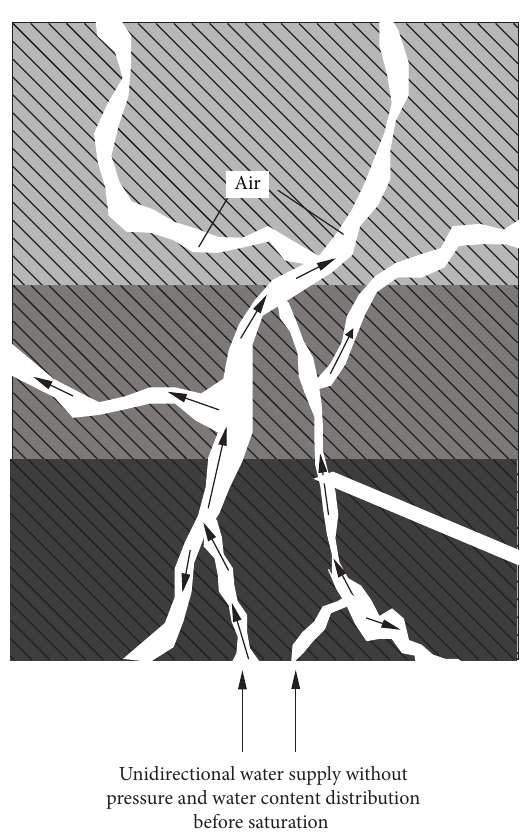
Figure 9: Sketch of water migration and water content distribution before saturation in Test